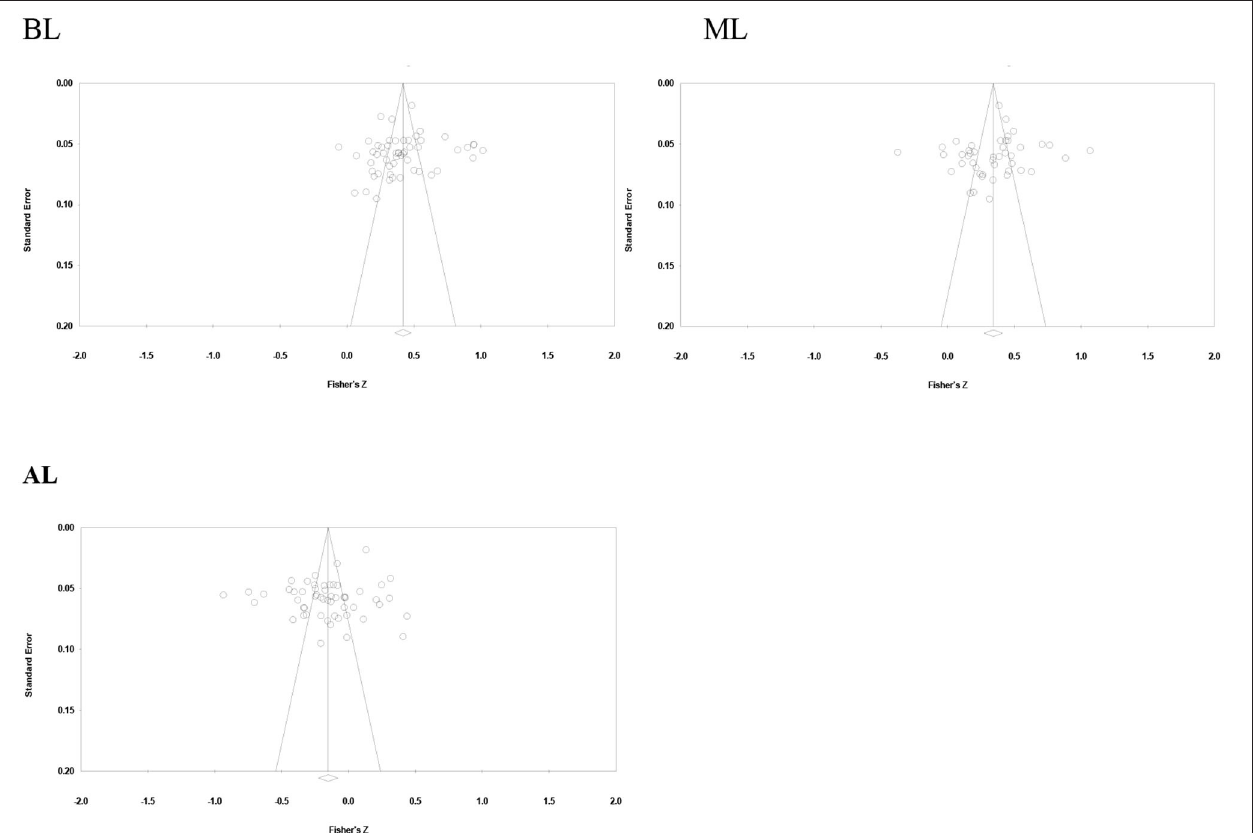
FIGURE 2 | Funnel plot; BL, benevolent leadership; ML, moral leadership; AL, authoritarian leadership.